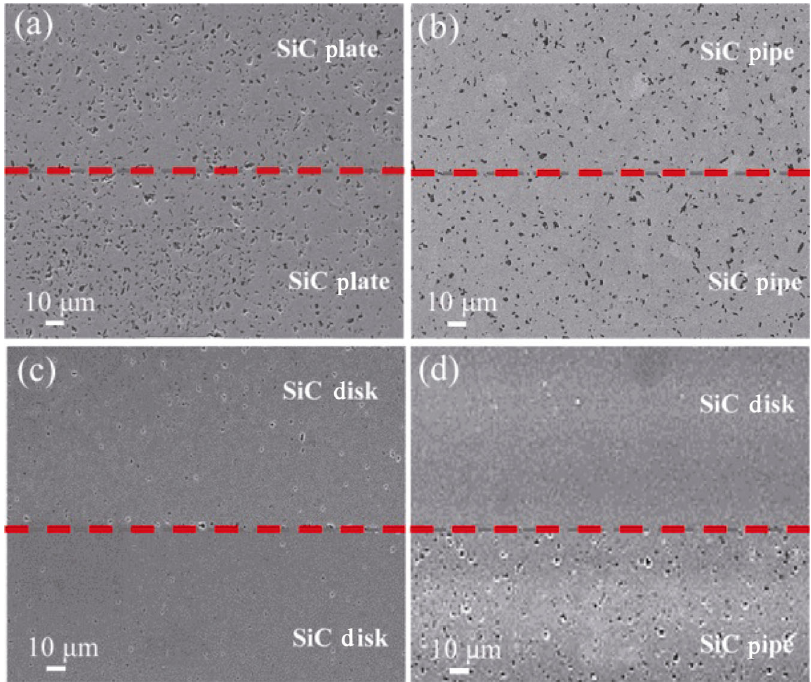
Fig. 4 Cross-sectional SEM images of SiC/SiC joints directly bonded by spark plasma sintering at 1900 ℃ , 30 min, 35 MPa: (a) plate couple, (b) pipe couple, (c) disk couple; (d) pipe  disk couple, showing good interfacial bonding and porosity difference in the SiC components. The red dashed lines were located at the bonding interfaces. Reproduced with permission from Ref. [23], © Taylor & Francis